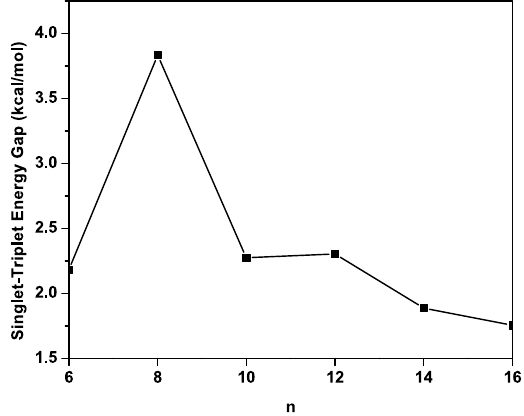
Figure 2. Singlet-triplet energy gap of Li 2 B n , obtained with TAO-BLYP-D.